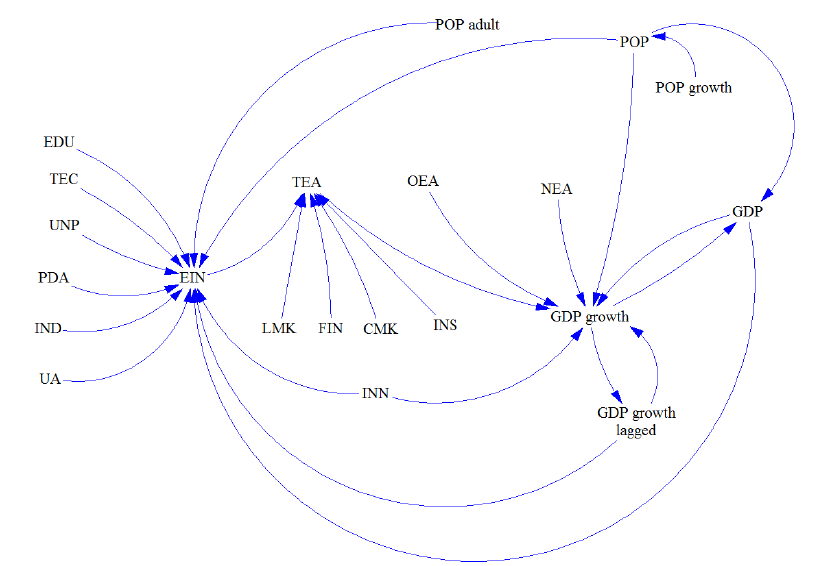
Fig. 2 . Conceptual causal diagram 3.2 Data and